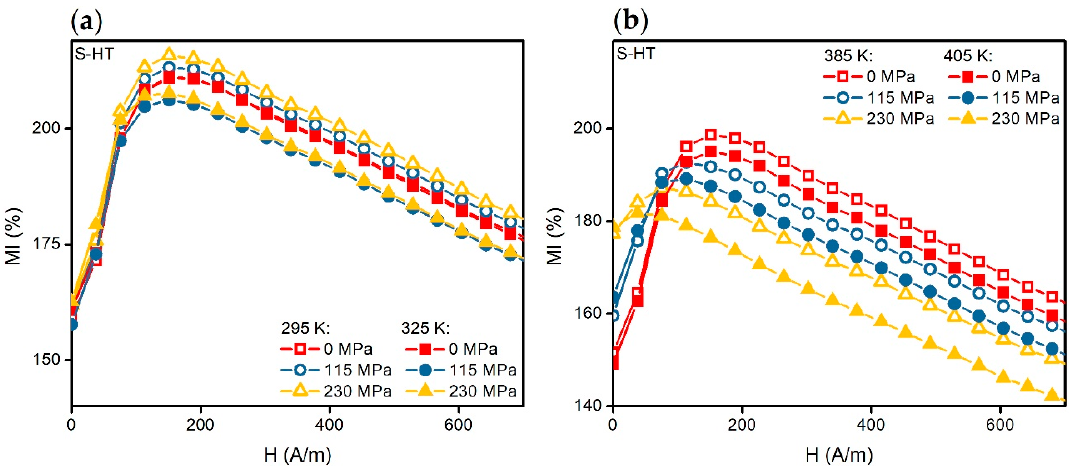
Figure 7. Magnetoimpedance dependencies MI ( H ) of the S-HT sample obtained at the temperatures: ( a ) 295 and 325 K; ( b ) 385 and 405 K. The dependencies are given for the alternating current frequency of 10 MHz and the tensile stresses of 0, 115 and 230 MPa.